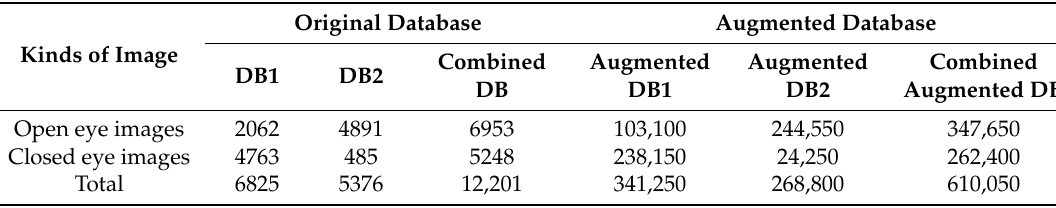
Figure 5. Creating images for augmented DB. Table 3. Descriptions of original and augmented databases.